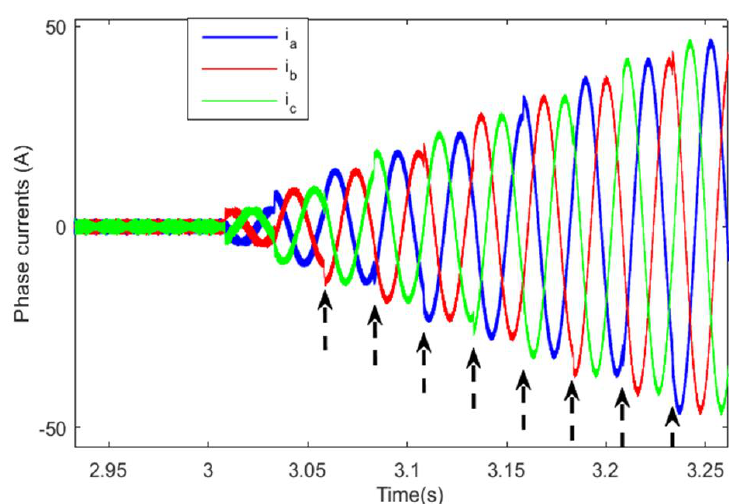
Figure 25. Front PMSM currents with the SBT.